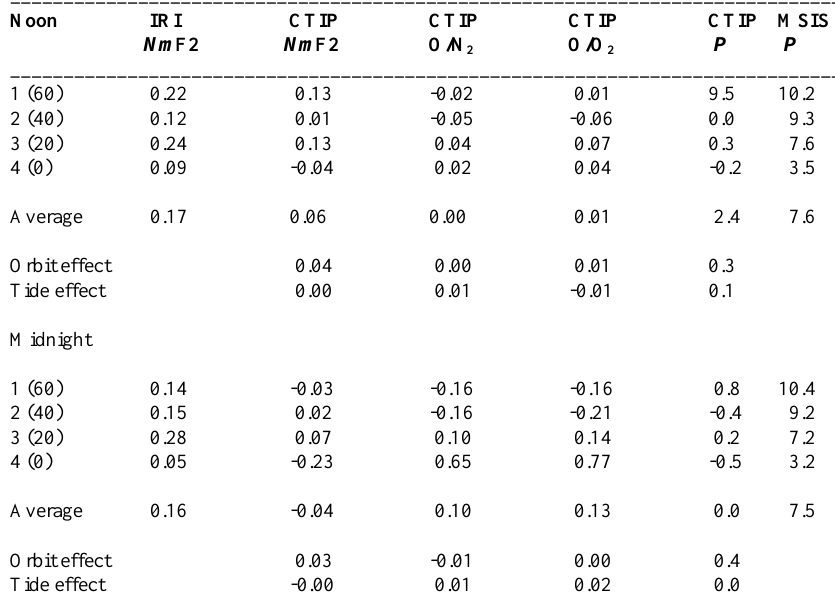
Table 3. Annual asymmetry for pairs of points at 162W, at magnetic latitudes 60, 40, 20 and 0. CTIP values include varying Sun Earth distance. Neutral composition is computed at a fixed pressure-level. For further details see text. The only ionosonde comparison is with Maui/Rarotonga near pair 3, namely 0.36 for noon, 0.25 for midnight. Orbit effect is the difference (actual Sun-Earth distance – 1AU). Tide effect is the difference (With tides) – (Without tides). Table